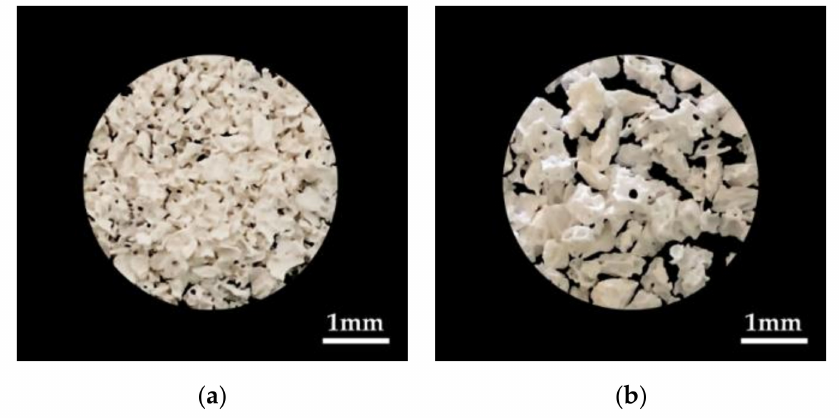
Figure 1. The bone graft materials used in our study. ( a ) Ti-oss ® ; ( b ) Bio-Oss ®